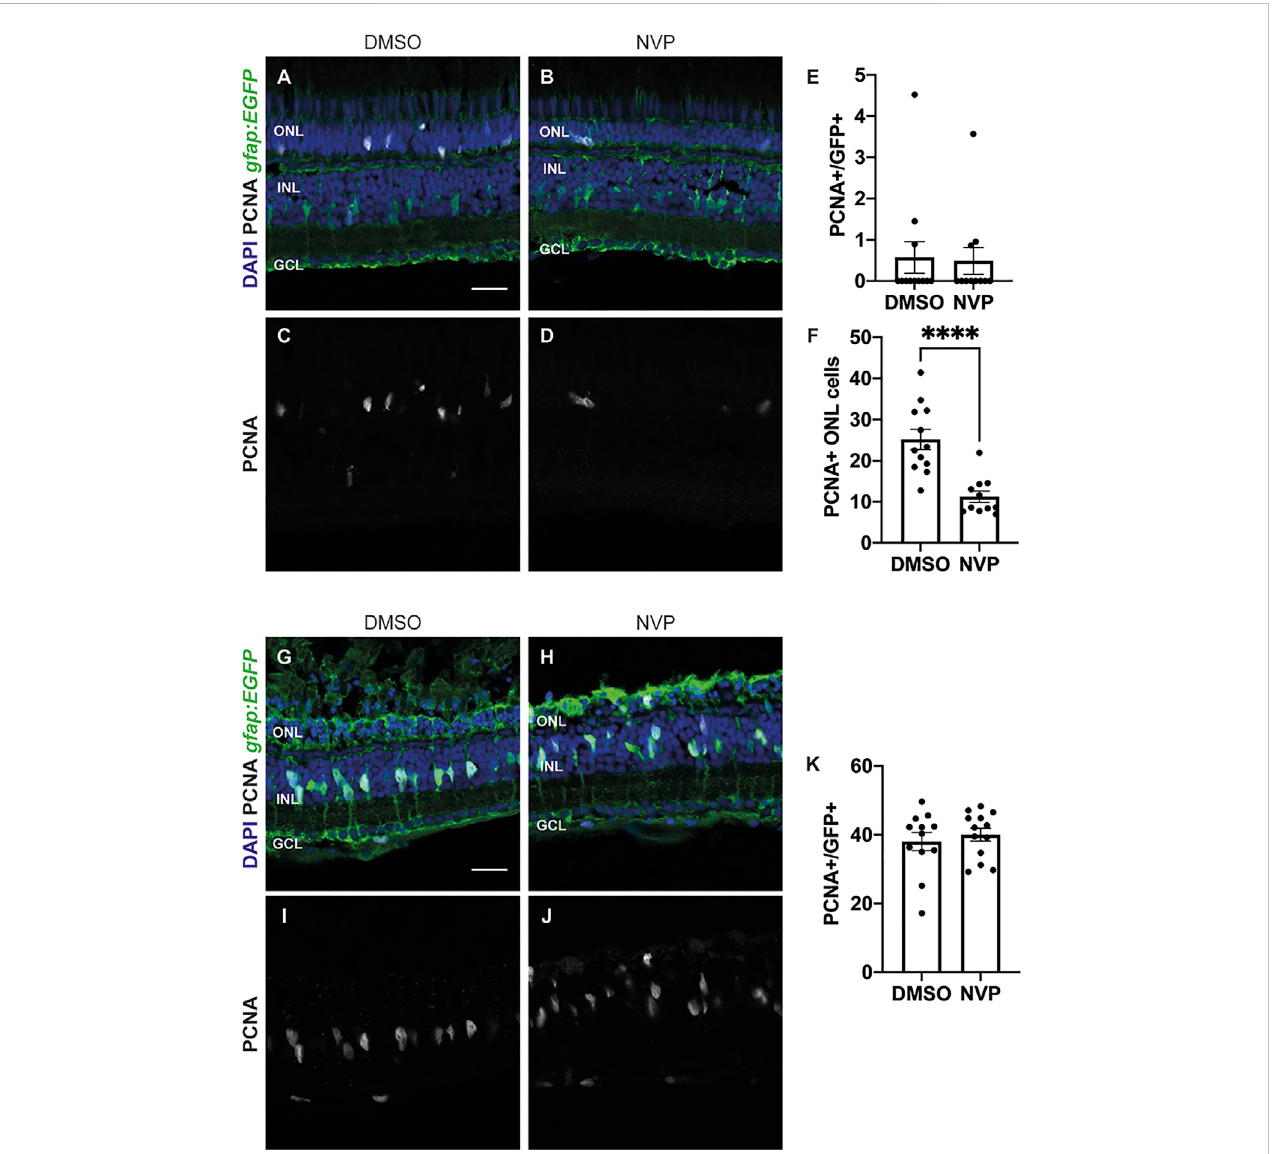
inhibitor NVP (B) for 72 h. Sections were labeled for GFP and PCNA to assess proliferating Müller glia and nuclei were counterstained with DAPI (C, D) . (E) Quanti fi cationshowingnosigni fi cantchangeinthenumberofPCNA-positiveMüllergliawithintheINLofNVP-treated fi sh.Student ’ s t -test, p =0.87,n ≥ 11. (F) Quanti fi cation showing signi fi cant decrease in the number of PCNA-positive cells within the ONL of NVP-treated fi sh. Student ’ s t -test, p = 0.0001, n ≥ 11. (G – J) Single confocal images from dark-adapted albino; Tg[gfap:EGFP] nt11 zebra fi sh which were light-treated for 36 h while receiving injections of